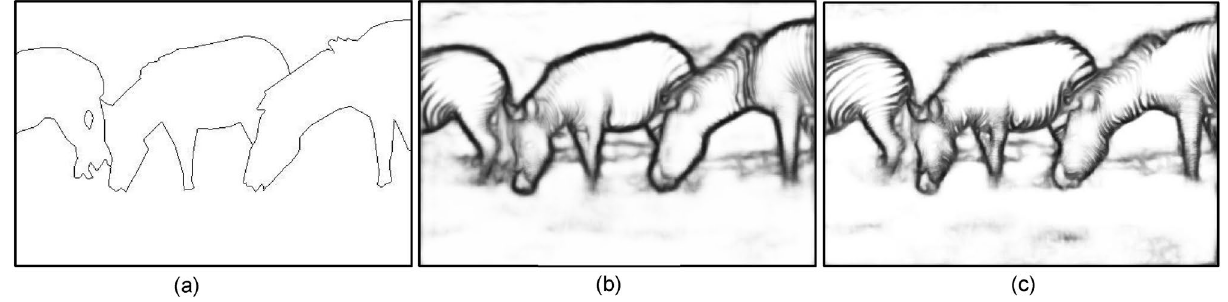
Figure 16. ( a ) GT form 8 . ( b ) RCF, (MQ, EQ, FoM) = (0.63, 0.46, 0.36). ( c ) HED, (MQ, EQ, FoM) = (0.65, 0.48,